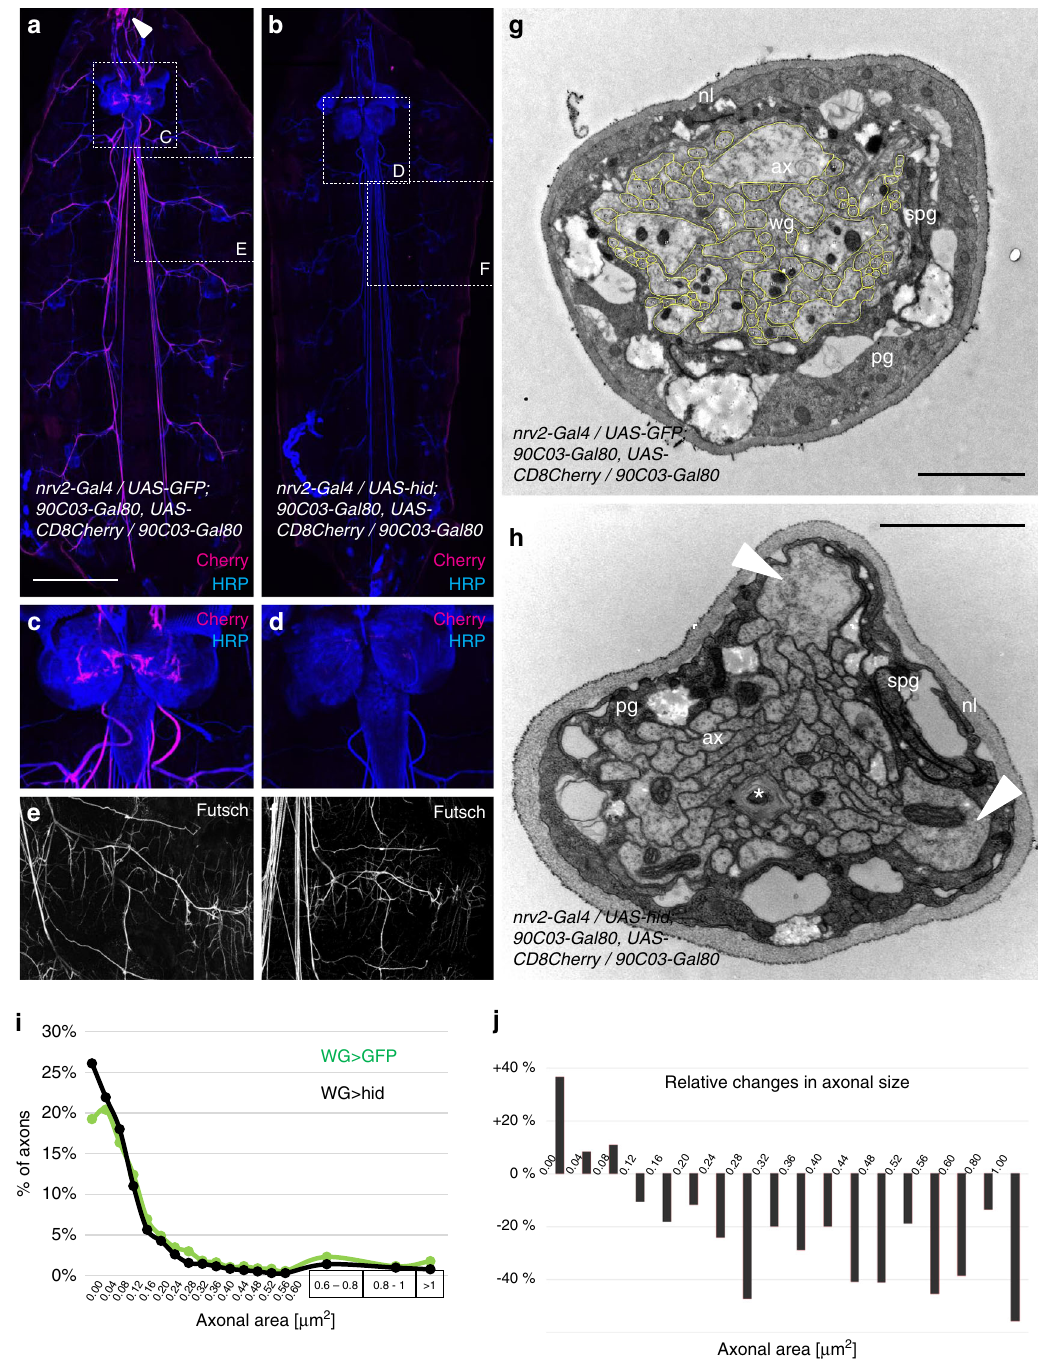
Fig. 5 Ablation of wrapping glia in abdominal nerves. a Confocal projection of a control third instar larval fi let preparation [ nrv2-Gal4 / UAS-GFP; 90C03-Gal80, UAS-CD8Cherry/90C03-Gal80 ]. Expression of CD8Cherry is observed in wrapping glia along abdominal nerves, in a structure close to the mouth hooks (arrowhead) and in few glial cells in the brain (see c ). Representative images are taken from >10 animals analyzed for each genotype. b Wrapping glia ablated third instar larva [ nrv2-Gal4/UAS-hid; 90C03-Gal80, UAS-CD8Cherry/90C03-Gal80 ]. Note the absence of CD8Cherry expression (see d ). Scale bars are 500 µ m. c Some brain glial cells express CD8Cherry in control larvae. d No CD8Cherry expression can be detected following hid expression. e , f Futsch expression as indicated, genotypes as in ( a , b ). Note the elaborated branching morphology of peripheral nerves. Upon wrapping glial ablation ( f ) Futsch expression remains unchanged compared to ( e ). g , h Electron microscopic images of segmental nerves at about 160 µ m distance to the ventral nerve cord of wandering third instar larvae. The specimens were fi xed and embedded in a fi lleted form. The size of the different axons was calculated using Fiji (yellow lines). Neural lamella (nl), perineurial glia (pg), subperineurial glia (spg), wrapping glia (wg), axon (ax). Scale bar is 2 µ m. Genotypes as in ( a , b ). g Cross-section of a control nerve. h Upon ablation of the wrapping glial cells, only possible remnants of the wrapping glia can be recognized (asterisk). Note that large caliber axons are usually found close to the glial cells of the blood-brain barrier (arrowheads). i The number of axons in the indicated size intervals is plotted for control (green) and wrapping glia ablated (black) nerves ( n = 1901 control axons and 1915 axons in glia ablated nerves, genotypes as in ( a , b ). j Relative changes in the number of axons in different axon size classes upon ablation of the wrapping glia compared to control animals. Note the increase in the number of small diameter axons and the reduction of larger caliber